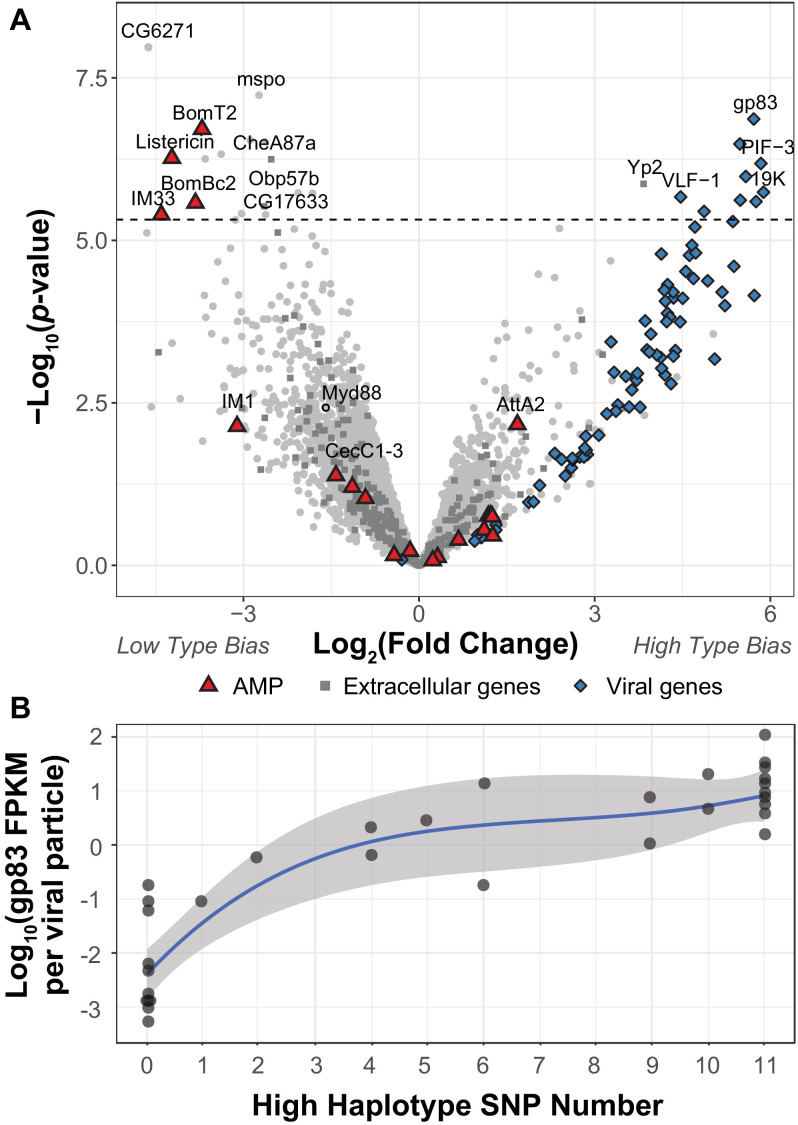
DIfferential expression between two viral haplotypes.(A) Differential expression of D. innubila and DiNV genes between D. innubila infected with either the Low type or High type DiNV multilocus genotypes. For host genes, the log-fold change of mRNA fragments per million fragments is compared, while for viral genes the log-fold change of viral mRNA fragments per million fragments per viral particle is compared. Genes are colored/labelled by categories of interest, specifically antimicrobial peptides (AMPs), proteins involved in the extracellular matrix and viral proteins. Specific genes of interest, such as Myd88, are also named. The FDR-corrected significance cut-off of 0.01 (10,320 tests) is shown as a dashed line. (B) Expression (in FPKM per viral particle) of gp83 increases with the number of High type SNPs.